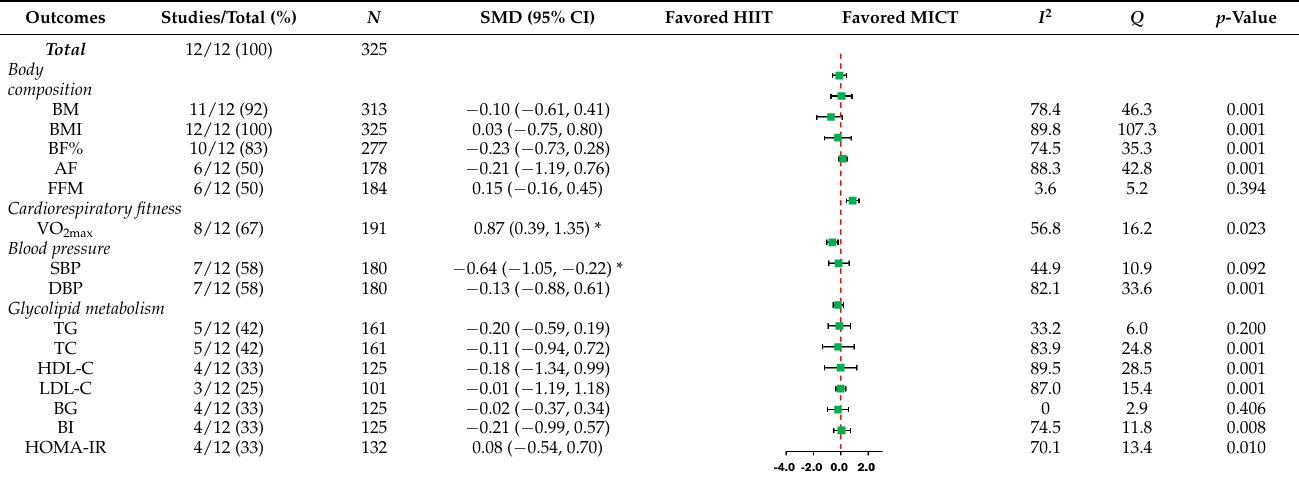
Table 5. Effects of HIIT and MICT on body composition, cardiorespiratory fitness, blood pressure and glycolipid metabolism indicators.